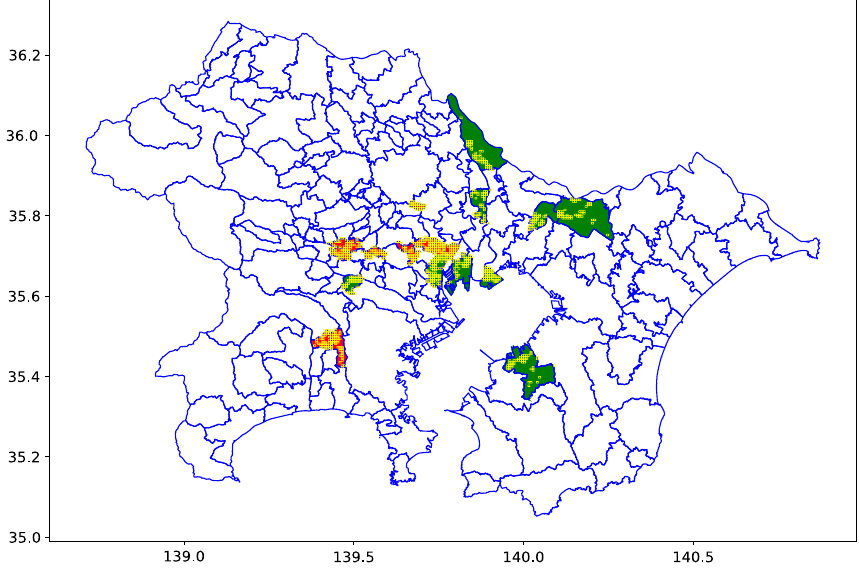
Figure 3. The distribution of the grids used in this study. The vertical axis, horizontal axis, and yellow squares represent the latitude, longitude, and grids used in this study, respectively. The red and green represent the municipalities with high and low population densities, respectively.